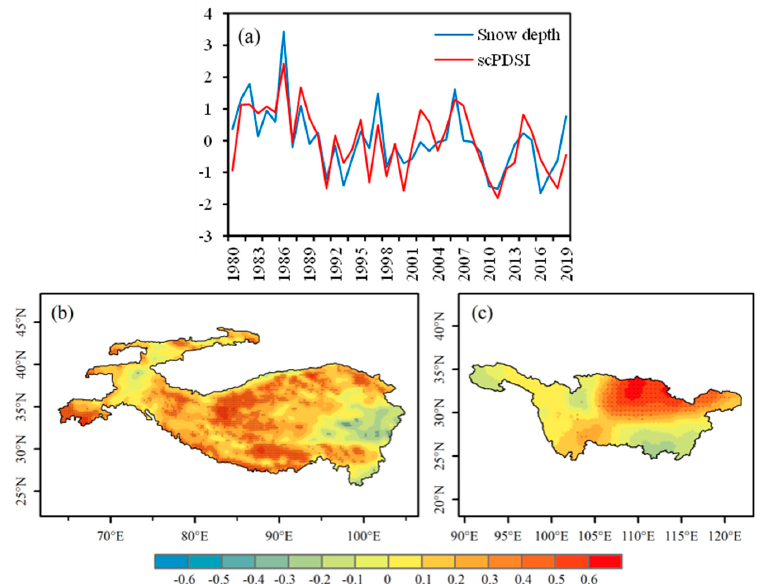
Figure 8. The spatial distributions of the left and right fields of the first SVD mode and their time series, derived from winter snow depth of HMA and the succeeding summer scPDSI of YRB during the period 1980–2019. ( a ) Normalized time series of winter snow depth (blue line) and summer scPDSI (red line)—units are arbitrary; ( b ) snow depth of HMA and ( c ) scPDSI of YRB—dotted area means passing significance test of 0.05.